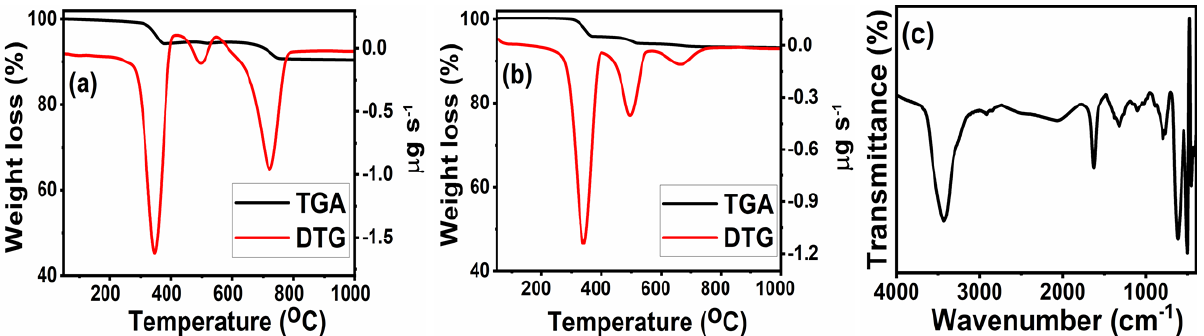
Figure 1. TGA-DTG curves of: ( a , b ) LZ-s and LNZ-s by the solid-state route; and ( c ) FT-IR spectrum of LZN-s after thermal degradation.